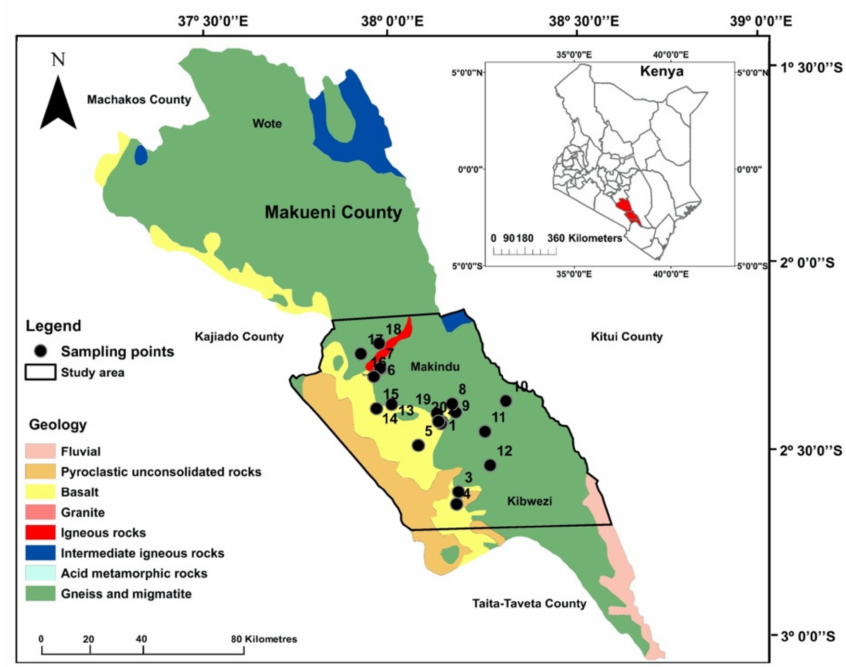
Figure 1. Map of Makueni County showing the location in Kenya and geology of the study area (bounded in black line). The selected households for the interviews were close to the water sampling locations (numbered 1–20) reported by Gevera et al. [6]. Figure adapted from Gevera et al.